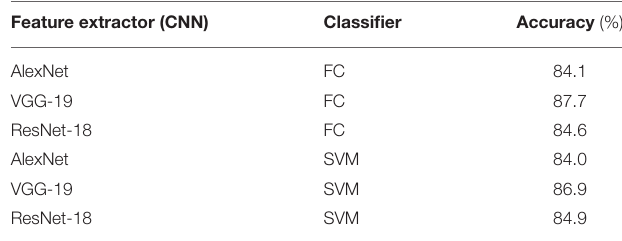
TABLE 2 | Results of the classification